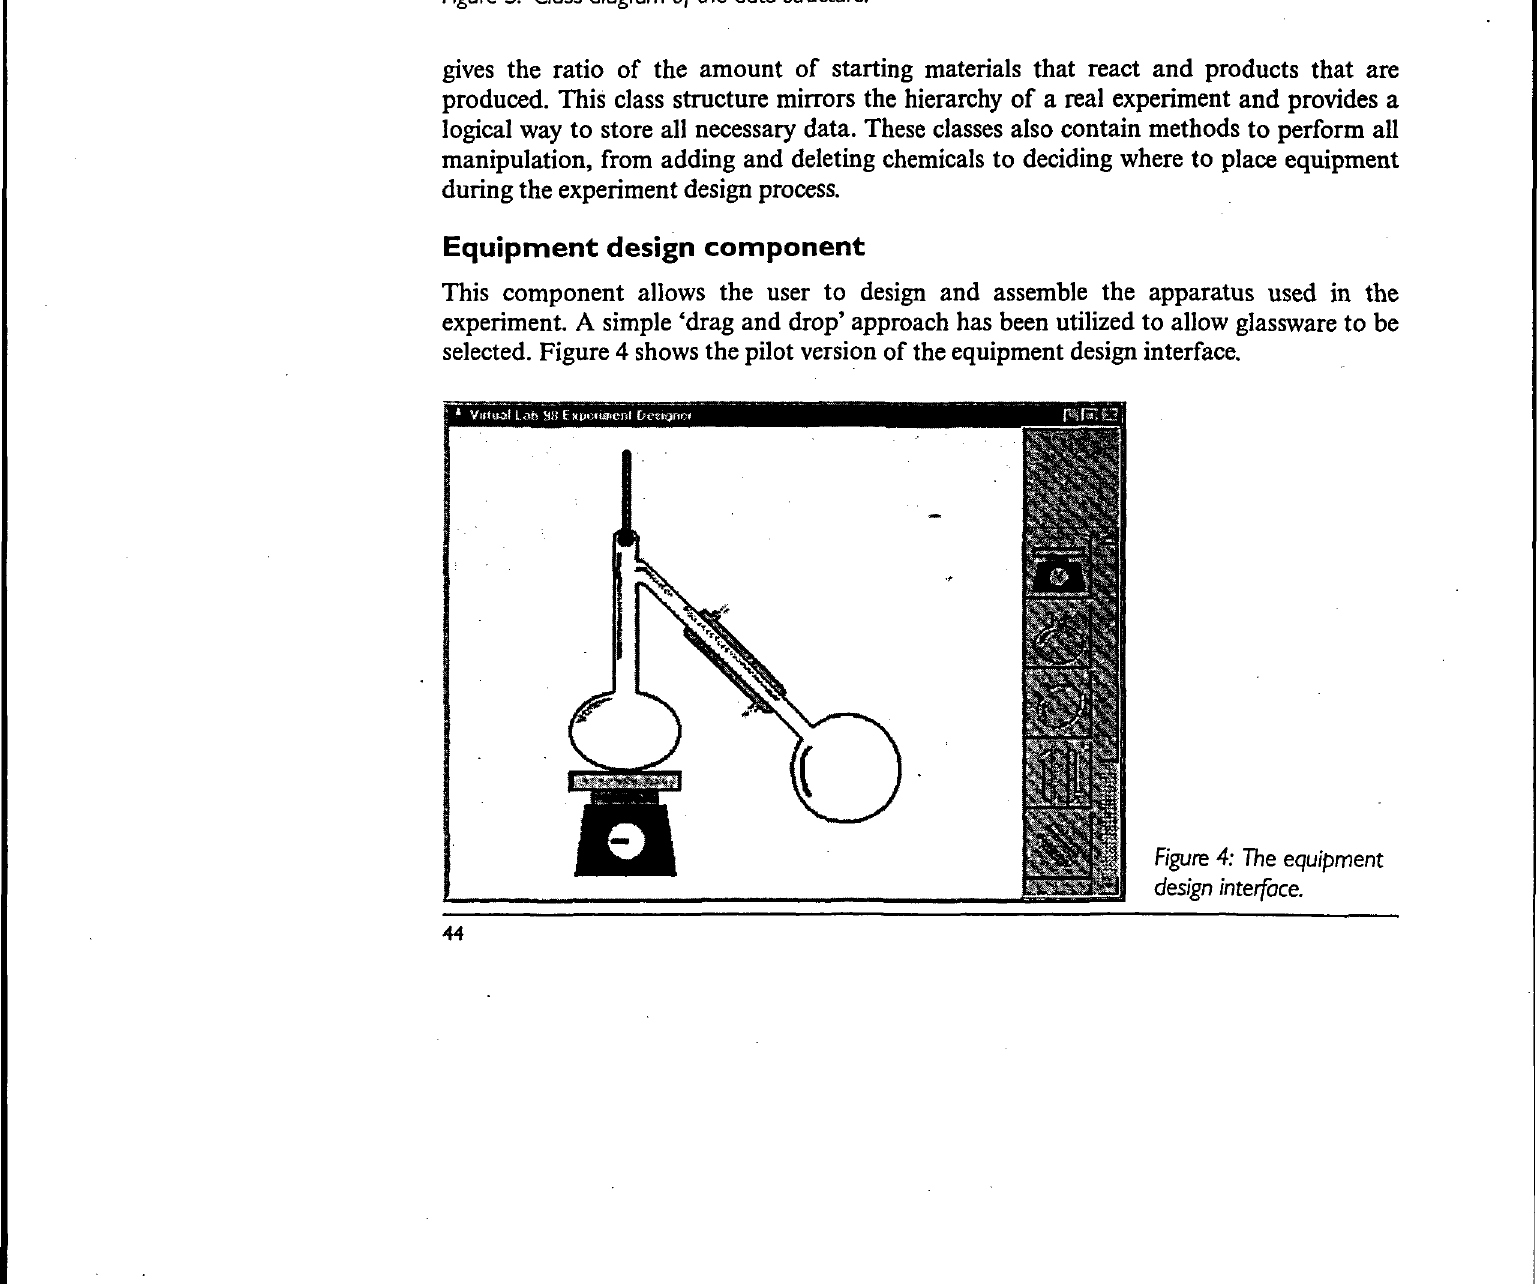
Figure 3: Class diagram of the data structure.